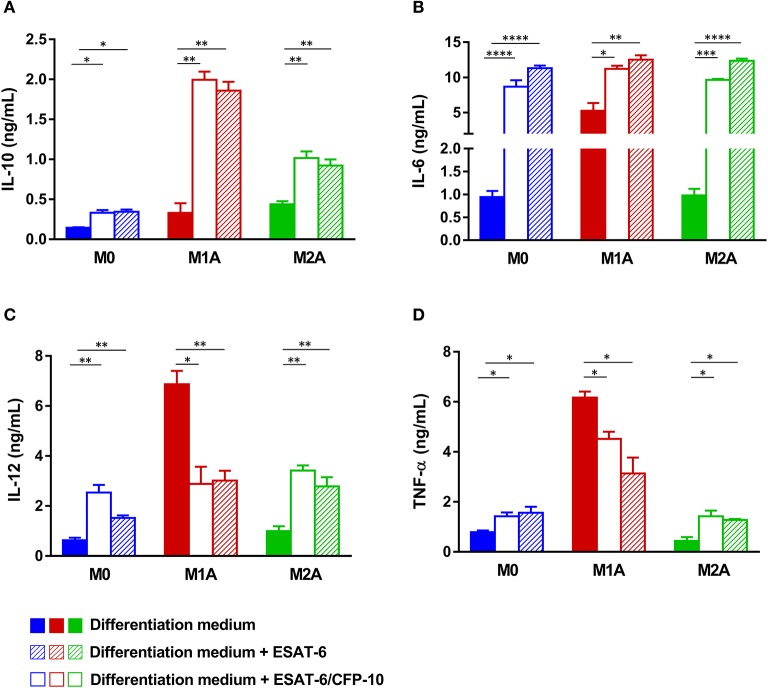
Both ESAT-6 and the physiologic ESAT-6/CFP10 complex inhibit secretion of M1A cytokines. After 6 days of MΦ differentiation as indicated in Figure 1, M1 MΦs were stimulated in presence or not of 10 μg/mL ESAT-6 in combination with 10 ng/mL LPS and 20 ng/mL IFN-γ to generate fully activated M1A MΦs. Fully activated M2A MΦs were generated by adding 20 ng/mL IL-4 and 20 ng/mL IL-13 to M2 differentiation medium, in presence or not of 10 μg/mL ESAT-6 as indicated in Figure 1. Assessment of the effects of the physiologic ESAT-6/CFP10 complex was similarly performed. After 24 h of incubation, supernatants were collected and secretion levels of (A) IL-10, (B) IL-6, (C) IL-12, and (D) TNF-α were assessed. Data are presented as the mean ± SD of 3 separate experiments (i.e. 3 different donors), each one carried out in triplicate (*p ≤ 0.05, **p ≤ 0.01, ***p ≤ 0.001).